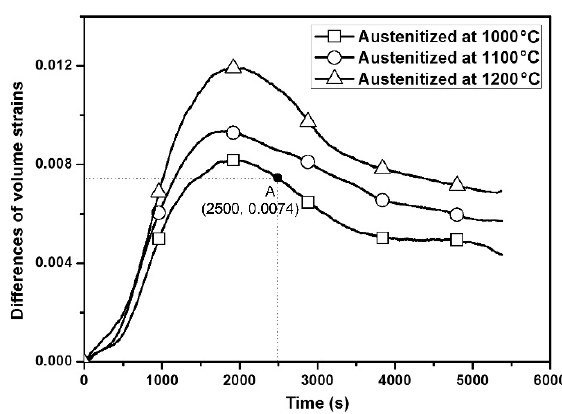
Figure 8. TP strain of different specimens during the bainitic transformation at 330 °C.